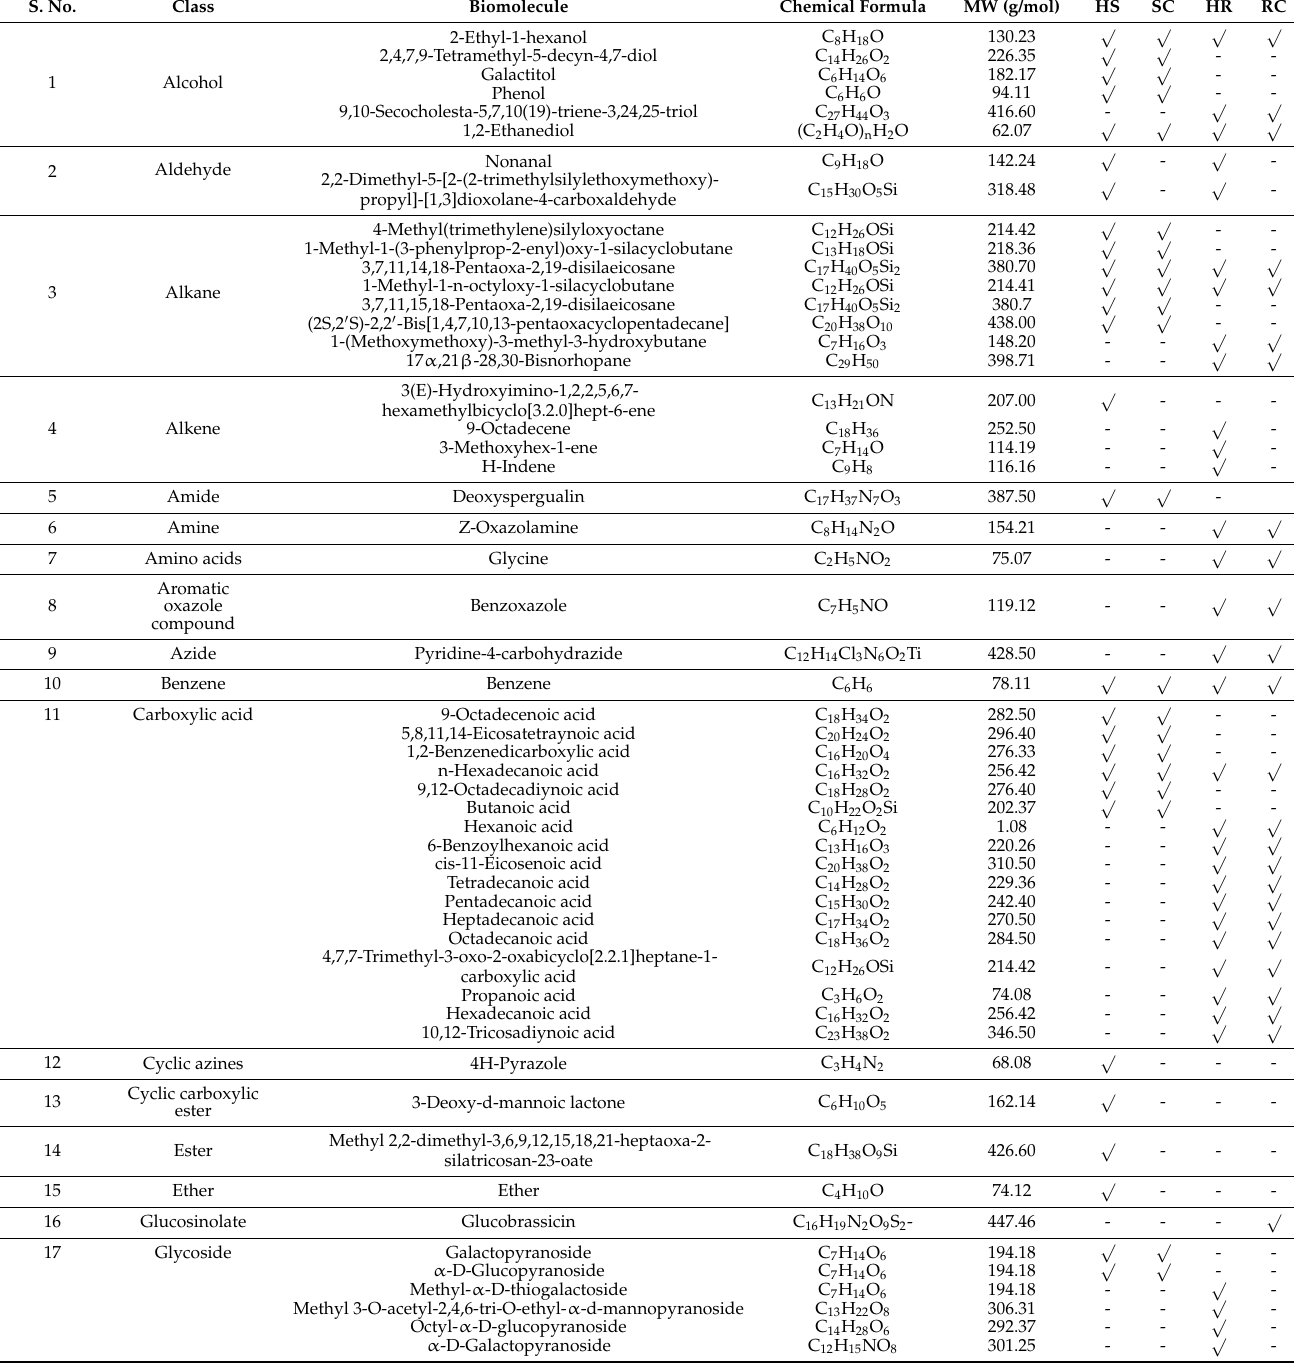
Table 5. Details of biomolecules expressed in horse gram in response to HgYMV